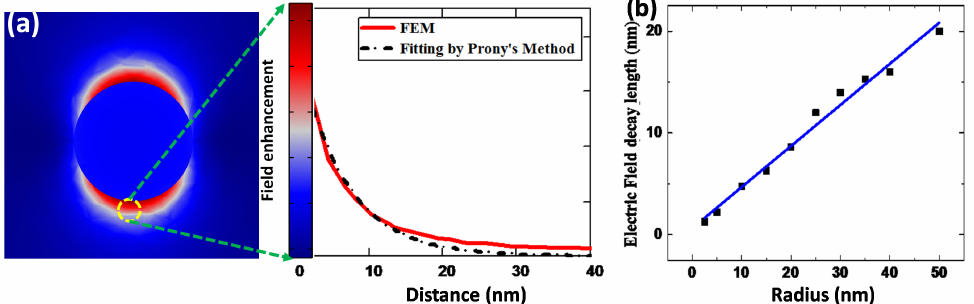
Figure 6. The calculation of l d values for gold nanosphere (r = 30 nm) using 3D full-wave field analysis in homogeneous medium n = 1.33 ( a ), and relation between particle radius versus l d ( b